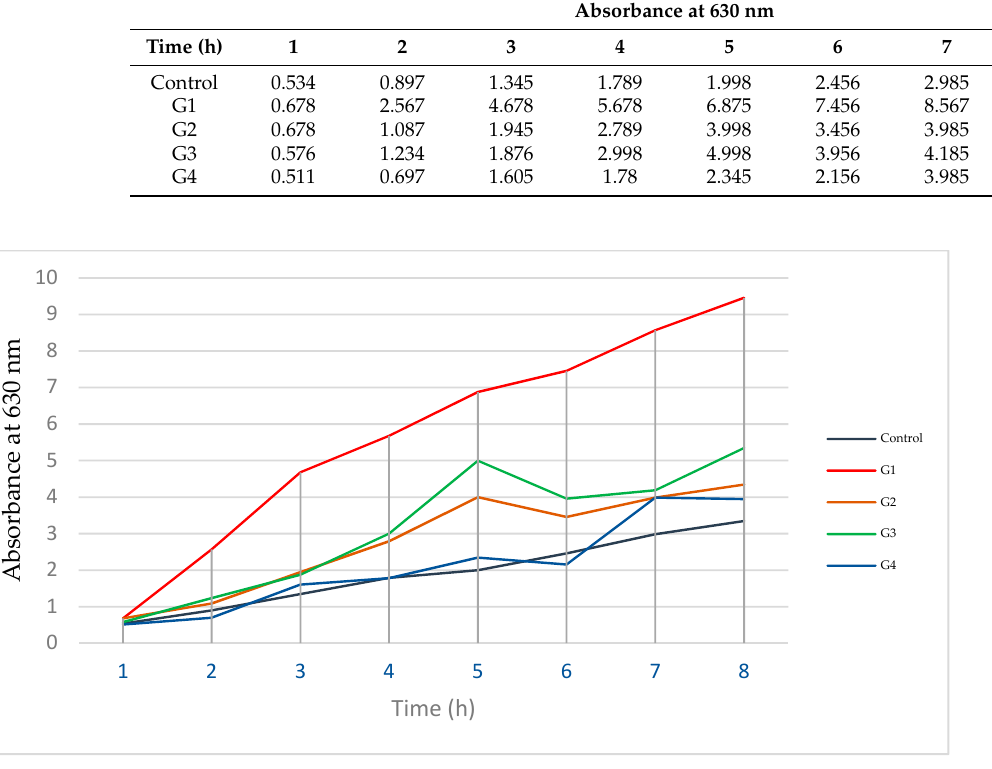
Figure 4. Hemoglobin autoxidation rate in rabbits injected with Gallium-68 with and without the application of protective antioxidants, single and combined doses, as compared with the control.